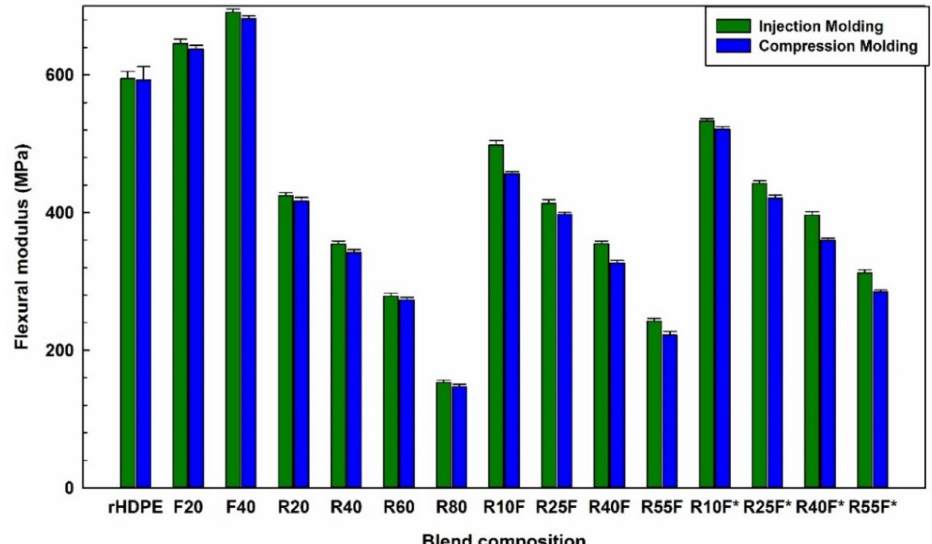
Figure 8. Flexural modulus of the composites (see Table 1 for